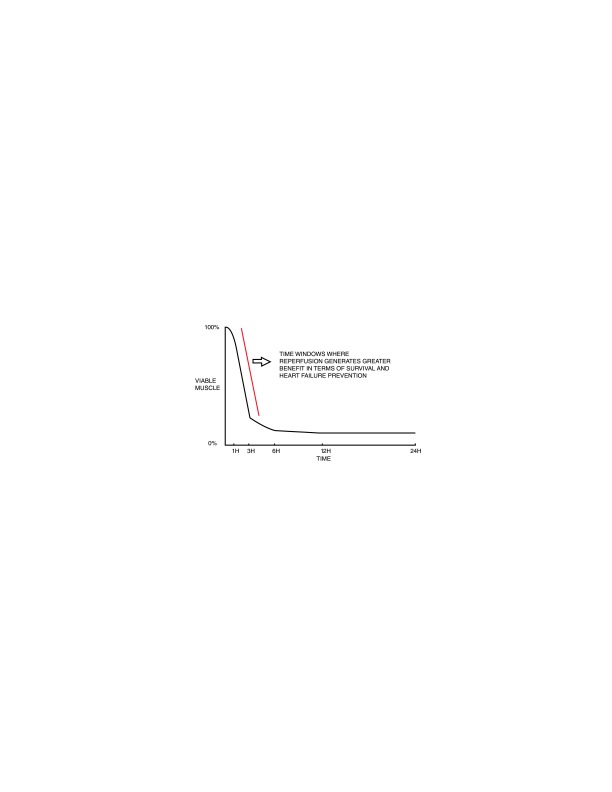
Relationship between time, extent of myocardial salvage, and mortality reduction.